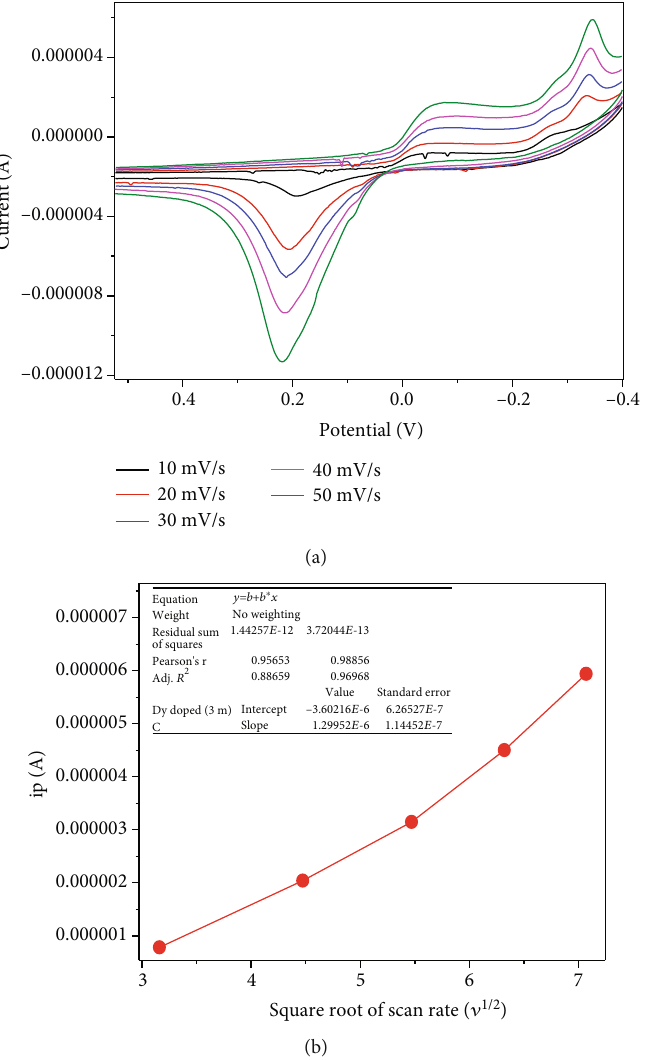
Figure 11: Cyclic voltammogram of Dy-doped (3mol%) ZrO cathodic peak current (ip) and the square root of scan rate ( ν 1/2 ) for Dy 3+ -doped (3 mol%) ZrO